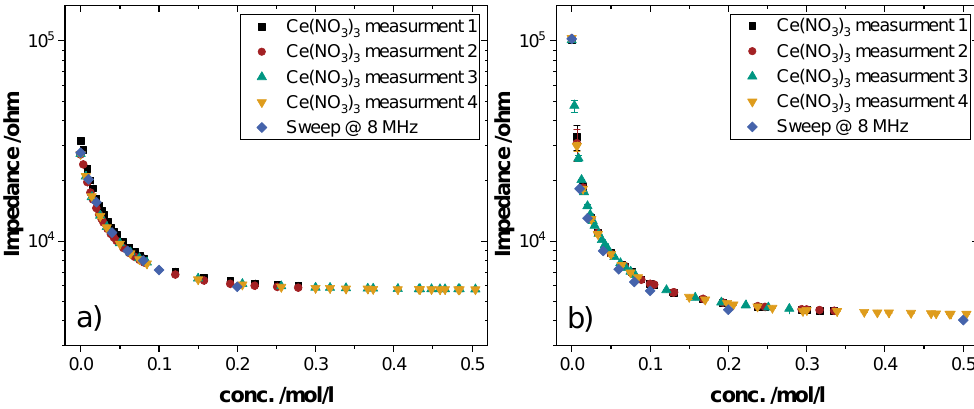
Figure 7. Impedance versus concentration of titration measurements. ( a ) electrode design Geo6 and ( b ) reactor electrode design Geo10. Every titration measurements were measured at 8 MHz.